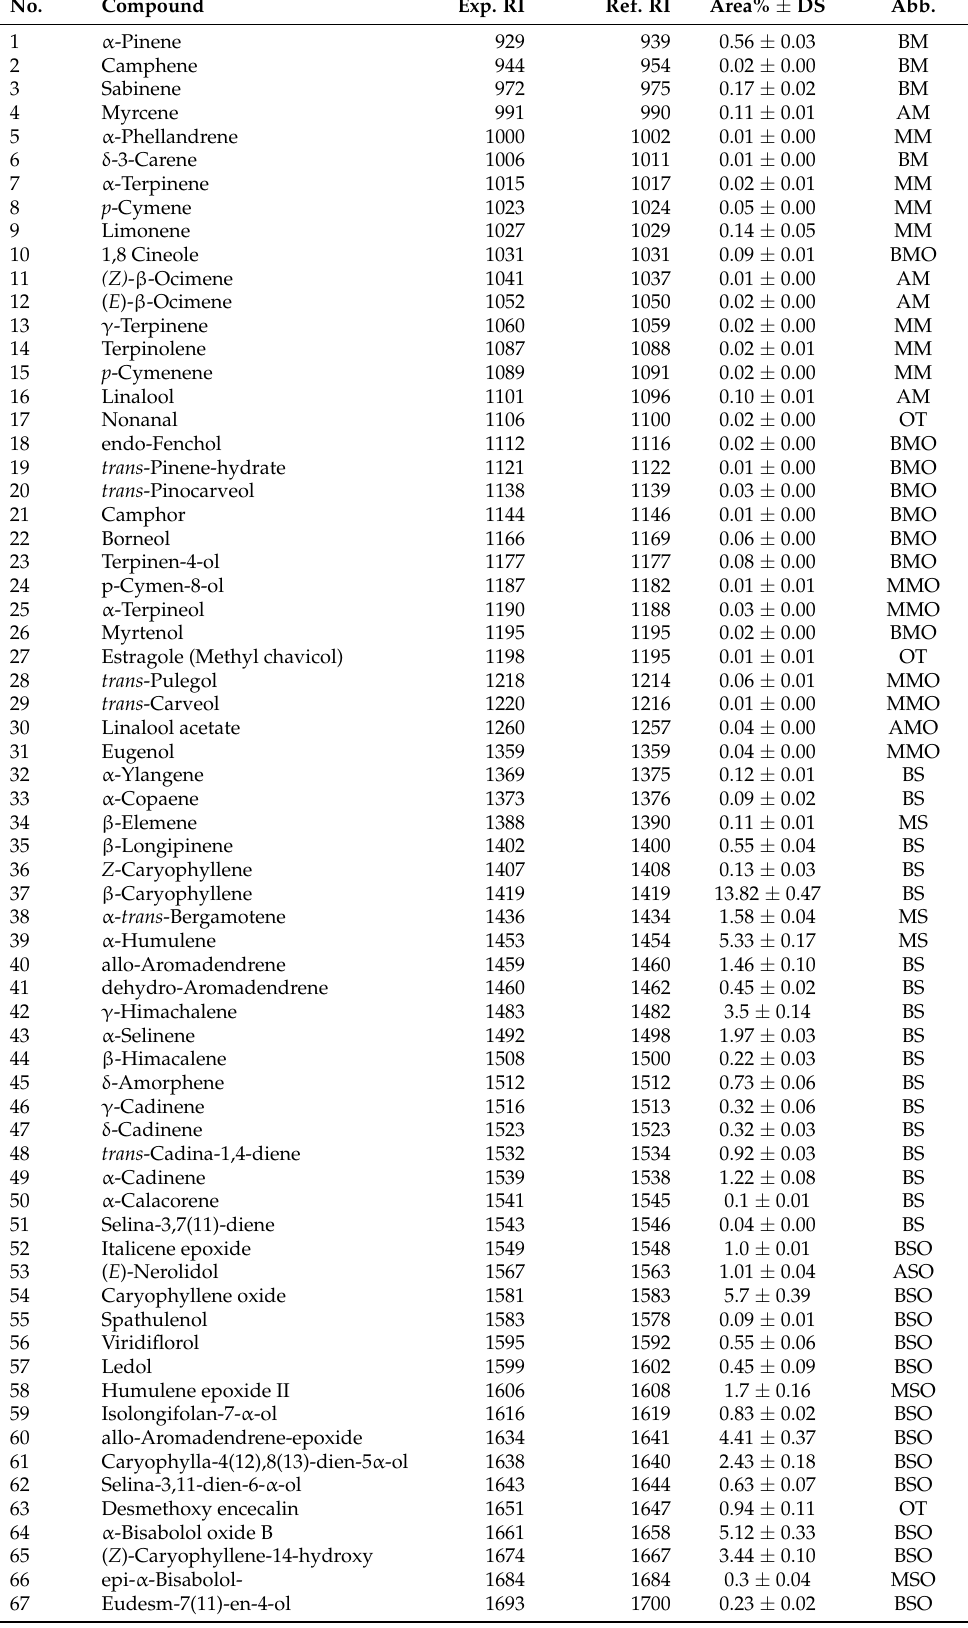
Table 2. Chemical composition of essential oils (EO) hydrodistilled from the leaves of C. sativa L. vr. Futura 75